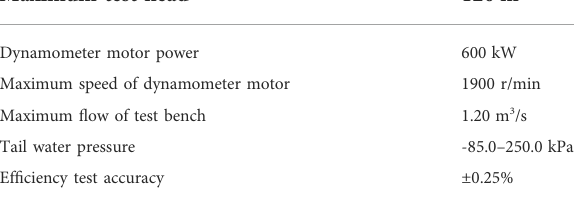
TABLE 1 Main parameters of the test